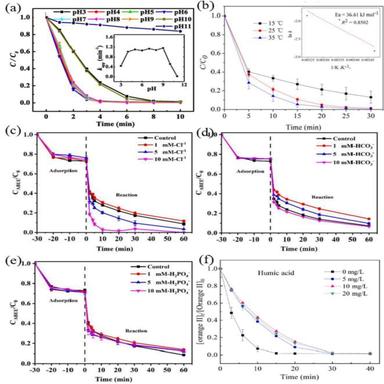
Performance and influence factors of MOFs-derived CMs in SR-AOPs. (a) pH . Copyright 2022 Elsevier. (b) Temperature . Copyright 2021 Elsevier. (c) (d) (e) anions . Copyright 2022 Elsevier. (f) Natural organic matter . Copyright 2021 Elsevier.